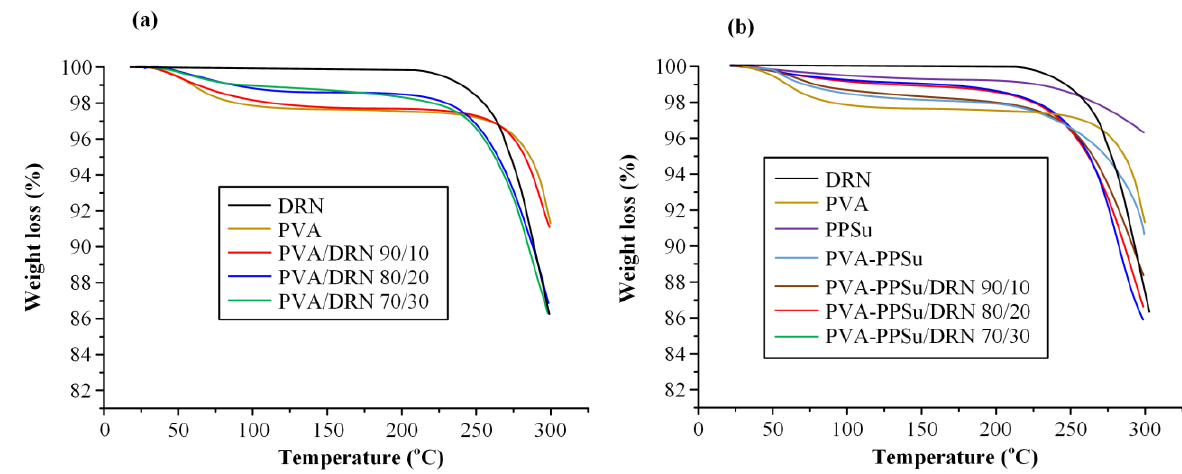
Figure 7. TGA thermograms of all raw materials along with PVA/DRN ( a ) and PVA-PPSu/DRN ( b ) samples at several weight ratios.